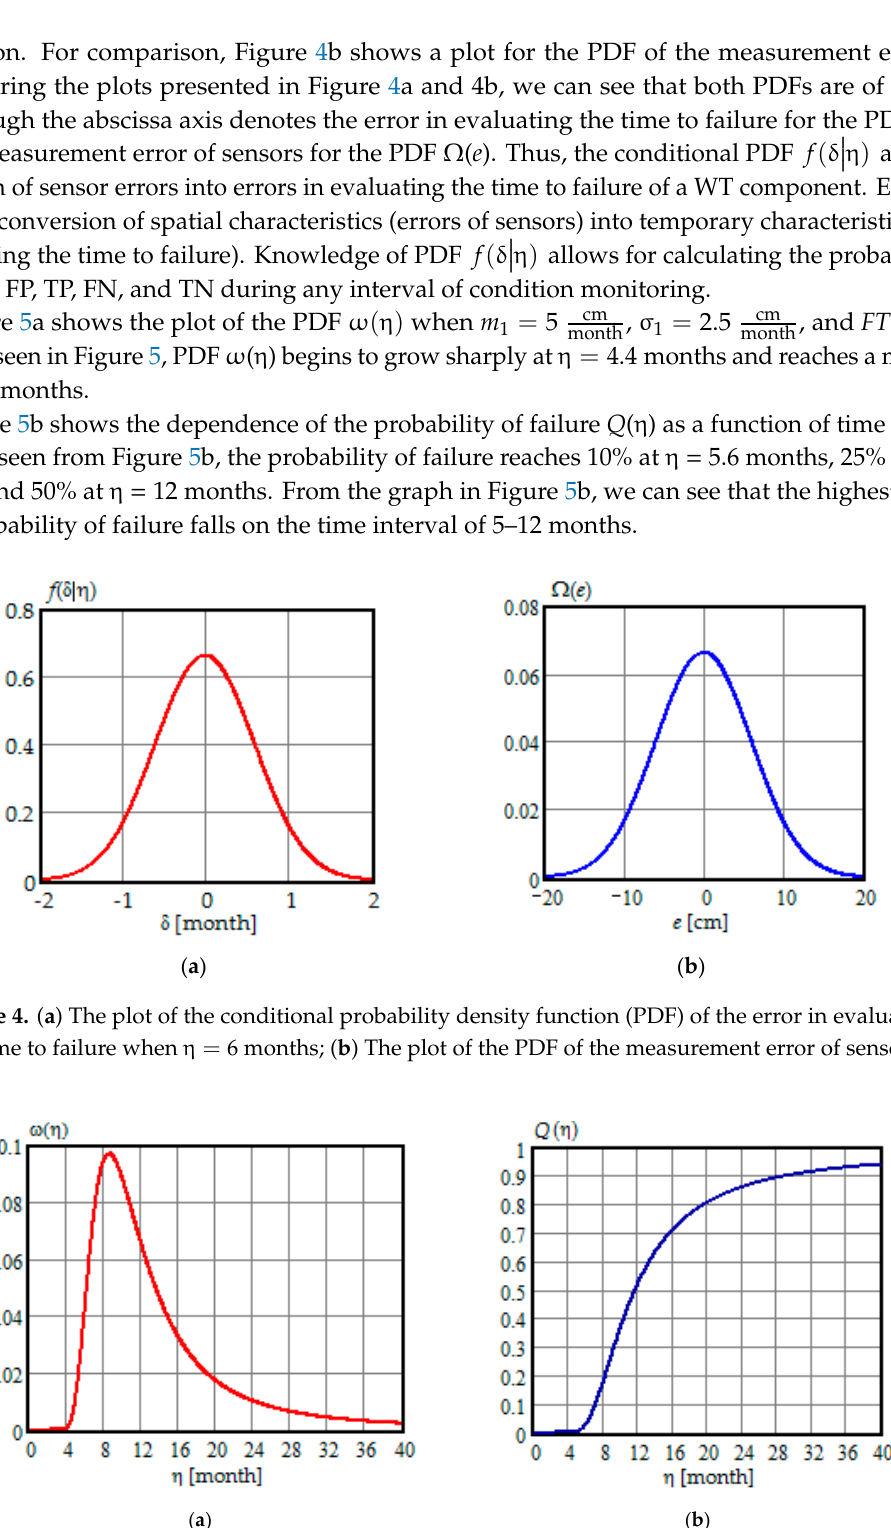
Figure 5. ( a ) Probability density function of time to failure; ( b ) Probability of failure.